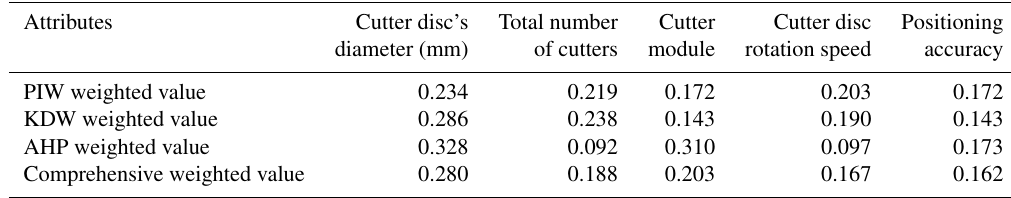
Table 6. Comprehensive weighted values of the cutter disc module